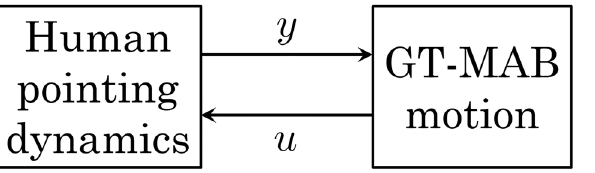
Figure 1. Block diagram of the closed-loop dynamics. Human generates wand movement y ( t ) while observing blimp movement u ( t